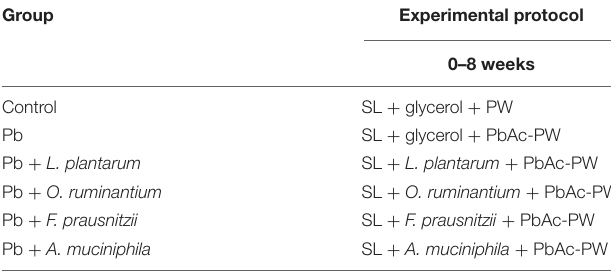
TABLE 2 | The protocol of animal experimental design